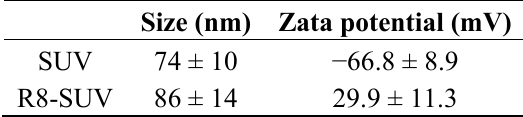
Table S2. Characteristics of SUV and